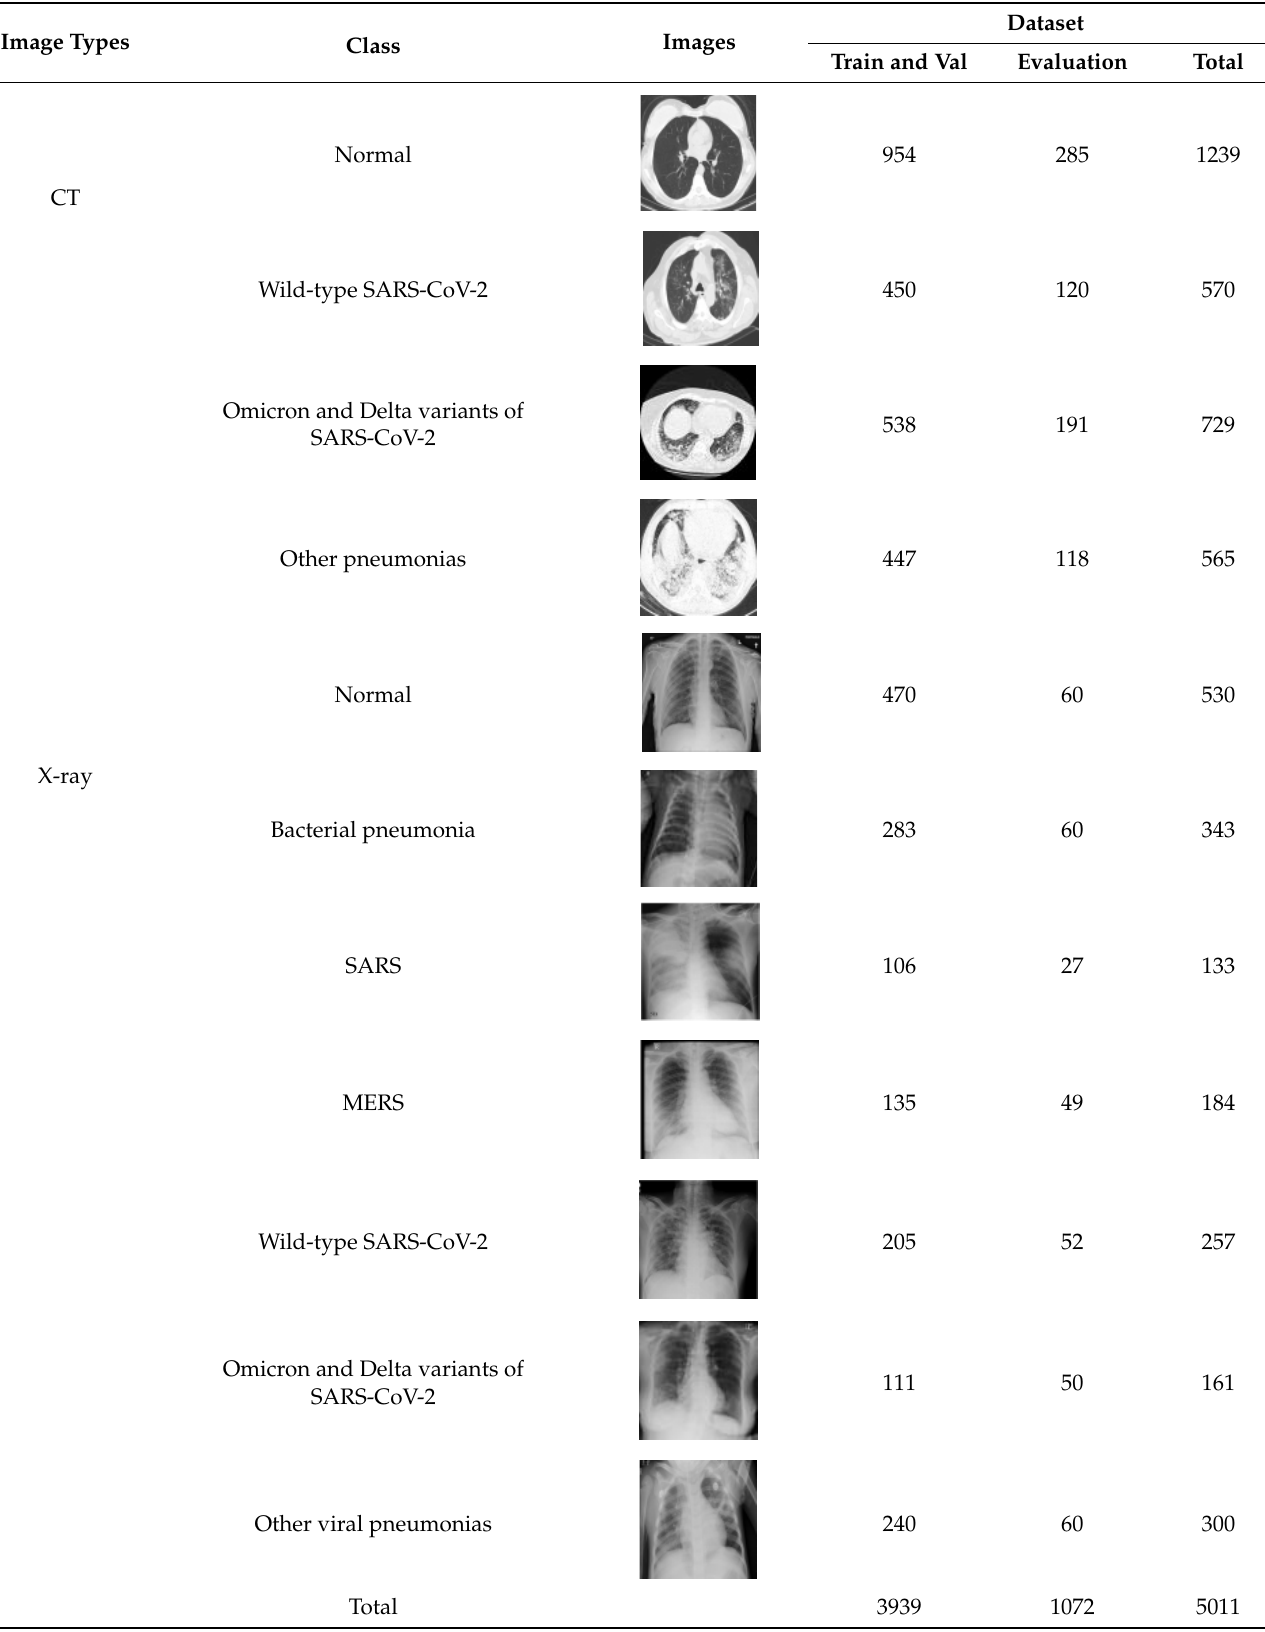
Table 1. Details of the CL-COVIDset dataset.